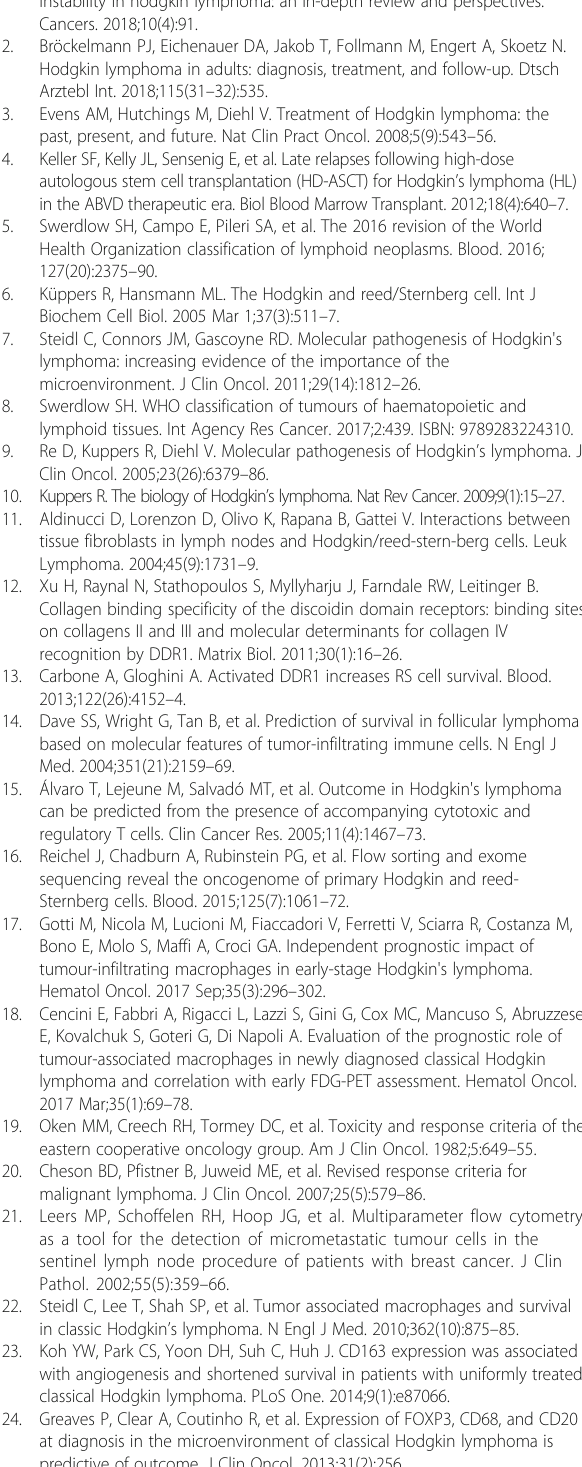
Additional file 1: Table S1. association between Disease free survival (DFS) and relevant clinic-pathological features of the patients. Table S2. association between overall survival rates (OS) and relevant clinic- pathological features of the patients. Abbreviations ABVD: Adriamycin, bleomycin, vinblastine, dacarbazine; BEACOPP: